Question: According to this chart, does the measure grow or shrink?
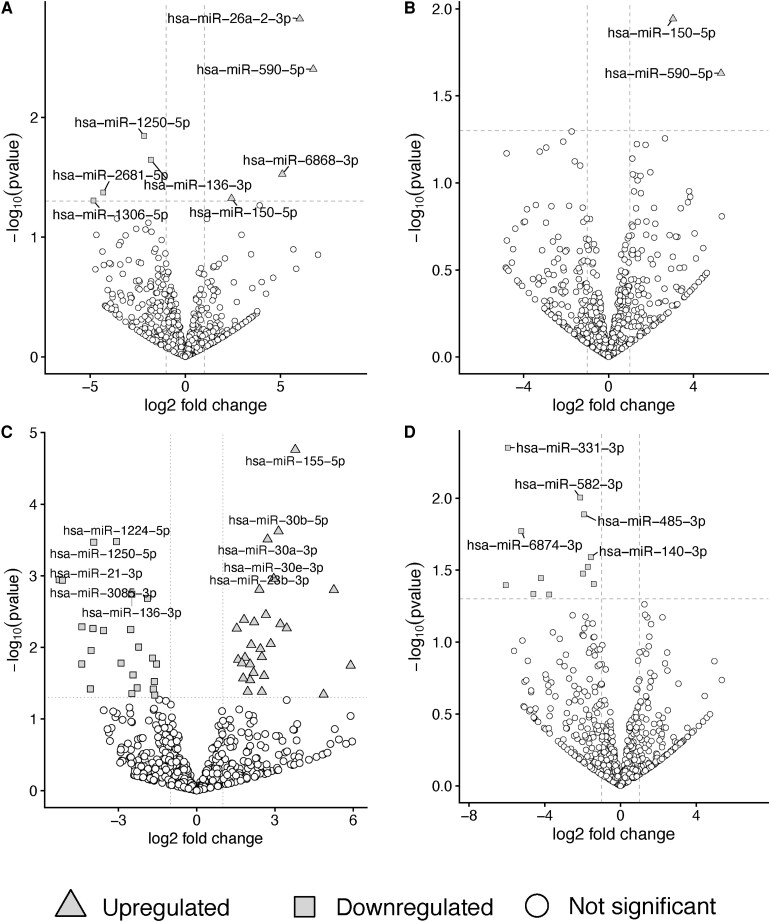
Answer: increasing